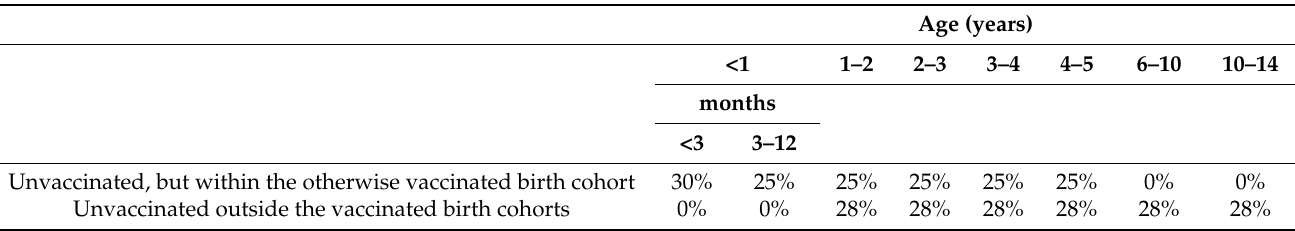
Table 6. Herd immunity for the population outside those vaccinated and the population born prior to the vaccinated cohort